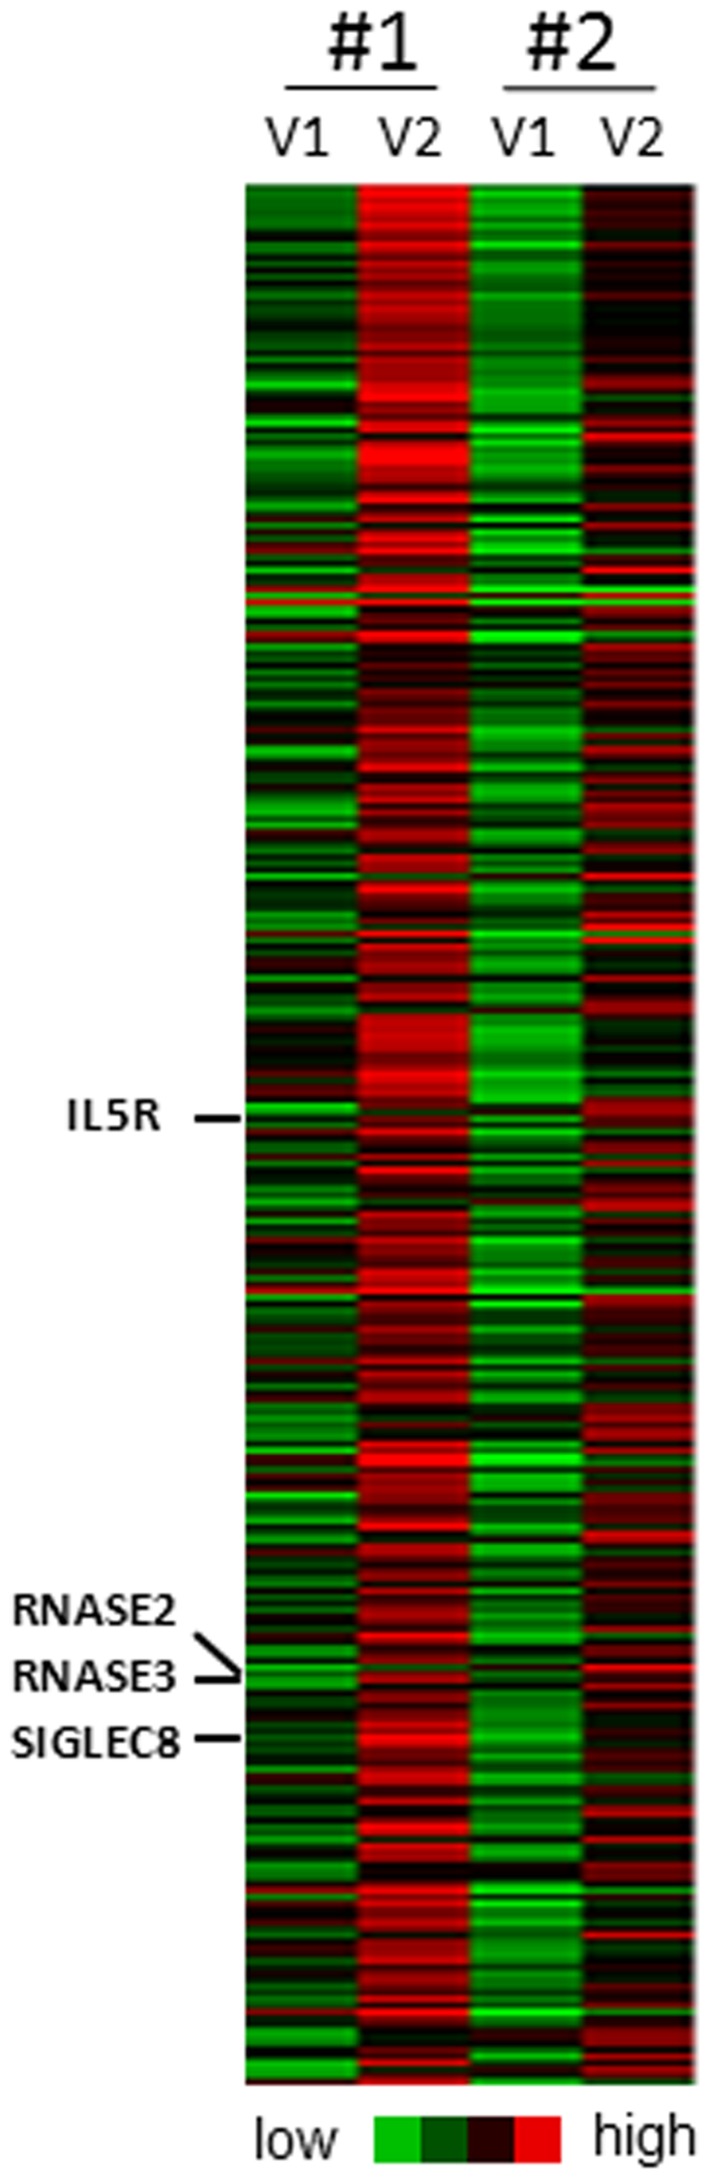
Heat map generated using Cluster 3.0 and presenting the 299 genes up-regulated by more than 2-fold in BAL cells from both subjects #1 and #2, 48 h after SBP-Ag (BAL V2 as shown in Figure 1) compared to before SBP-Ag (V1).Eosinophil-markers (IL5RA, RNASE2, RNASE3 and SIGLEC8) are highlighted. The full list of gene names is presented on Table S2.